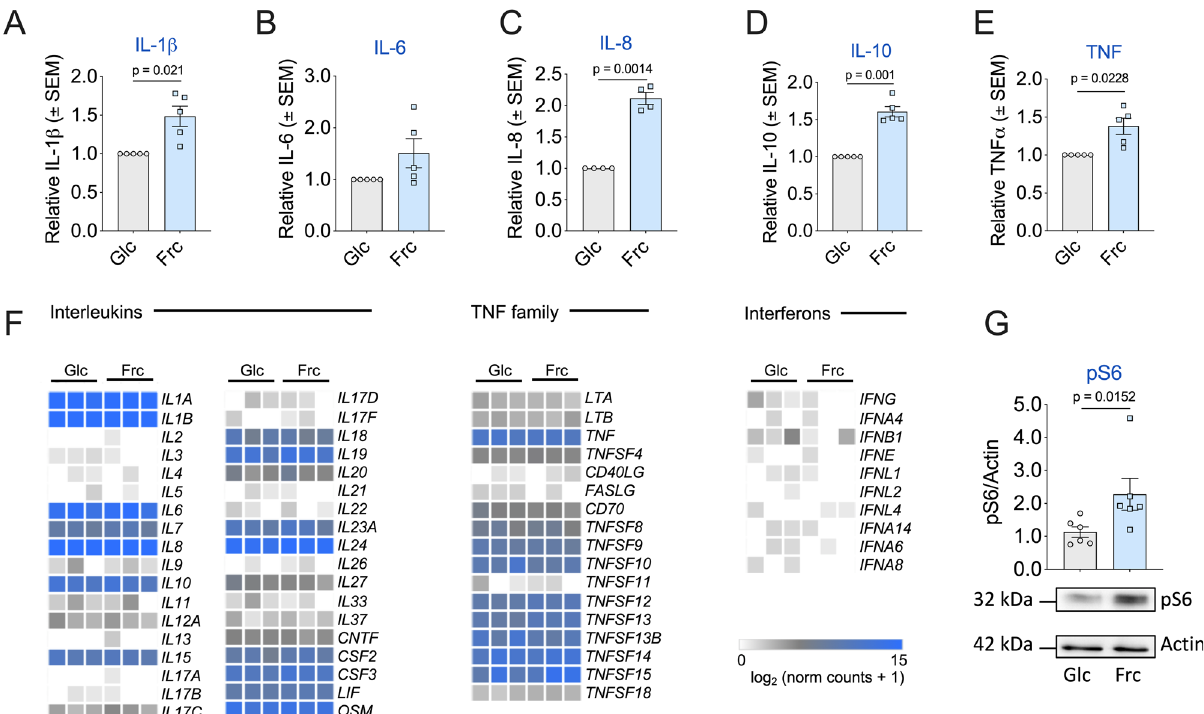
Fig. 3 Fructose promotes a more in fl ammatory phenotype. Extracellular cytokine release of A IL-1 β , B IL-6, C IL-8, D IL-10 and E TNF. F Heatmaps displaying the normalised read counts of selected cytokines from RNA-seq analysis of monocytes treated with glucose or fructose (both 11.1 mM) stimulated with LPS (10 ng/mL) for 24 h. G Representative immunoblot and pooled data of downstream mTOR target pS6 with housekeeping control, actin. Statistical signi fi cance was assessed using a one-sample t test ( A – E ) or an unpaired, two-tailed t test ( G ). Data are representative of fi ve ( A , B , D , E ), four ( C ), three ( F ) and six independent experiments ( G ) and are expressed as mean ± SEM. Source data are provided as a Source Data fi